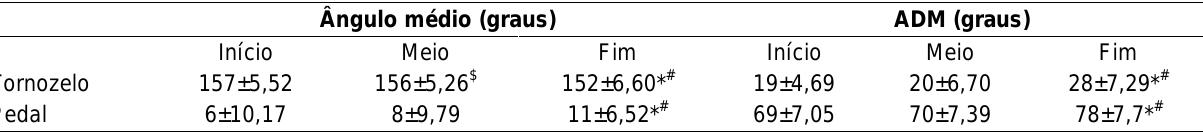
Tabela 2. Média e desvio-padrão do ângulo médio da articulação do tornozelo e do pedal e amplitude de movimento (ADM) do ângulo da articulação do tornozelo e do ângulo do pedal dos ciclistas avaliados